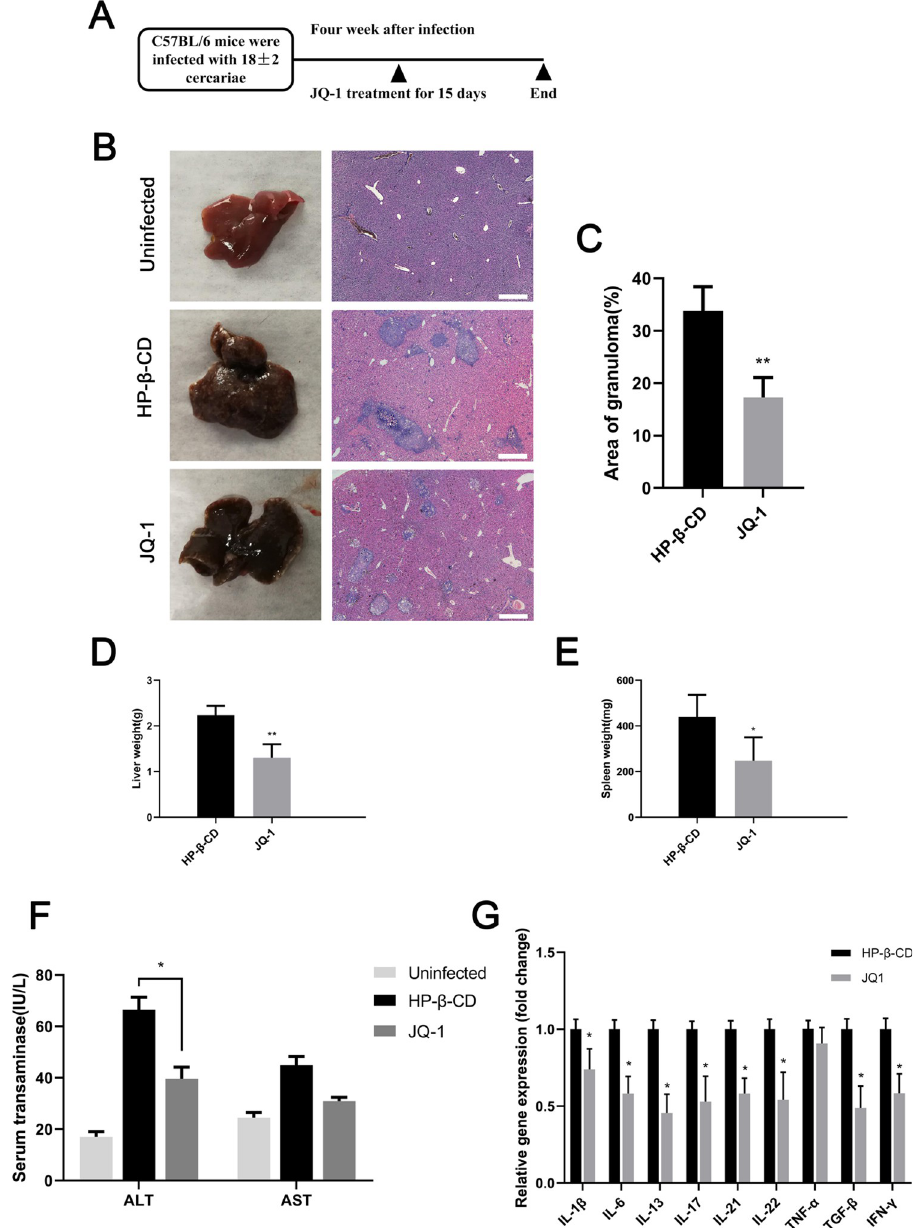
Fig 6. Effect of JQ-1 treatment on liver granuloma in mice infected with S . japonicum . (A) Protocol used to assess liver granuloma in mice. (B) Gross appearance of livers obtained from mice infected with S . japonicum and treated with JQ-1 or vehicle (HP- β -CD). Liver slices stained with hematoxylin and eosin. Scale bars: 500 μ m. (C) Measurement of granuloma area as a percentage of total area as assessed by computer-aided morphometry. (D) Liver weights of S . japonicum infected mice treated with JQ-1 or HP- β -CD. (E) Spleen weights of S . japonicum infected mice treated with JQ-1 or HP- β -CD. (F) Effect of JQ-1 treatment on serum alanine aminotransferase (ALT) and aspartate aminotransferase (AST) in mice infected with S . japonicum . (G) Effect of JQ-1 treatment on mRNA expression of inflammation-related genes in the liver of mice infected with S . japonicum . Data represent the mean ± SEM (n = 9 for each group). Asterisks denote statistically significant differences (Student’s t-test, � P < 0.05; �� P < 0.01) vs. the HP- β - CD–treated control group.